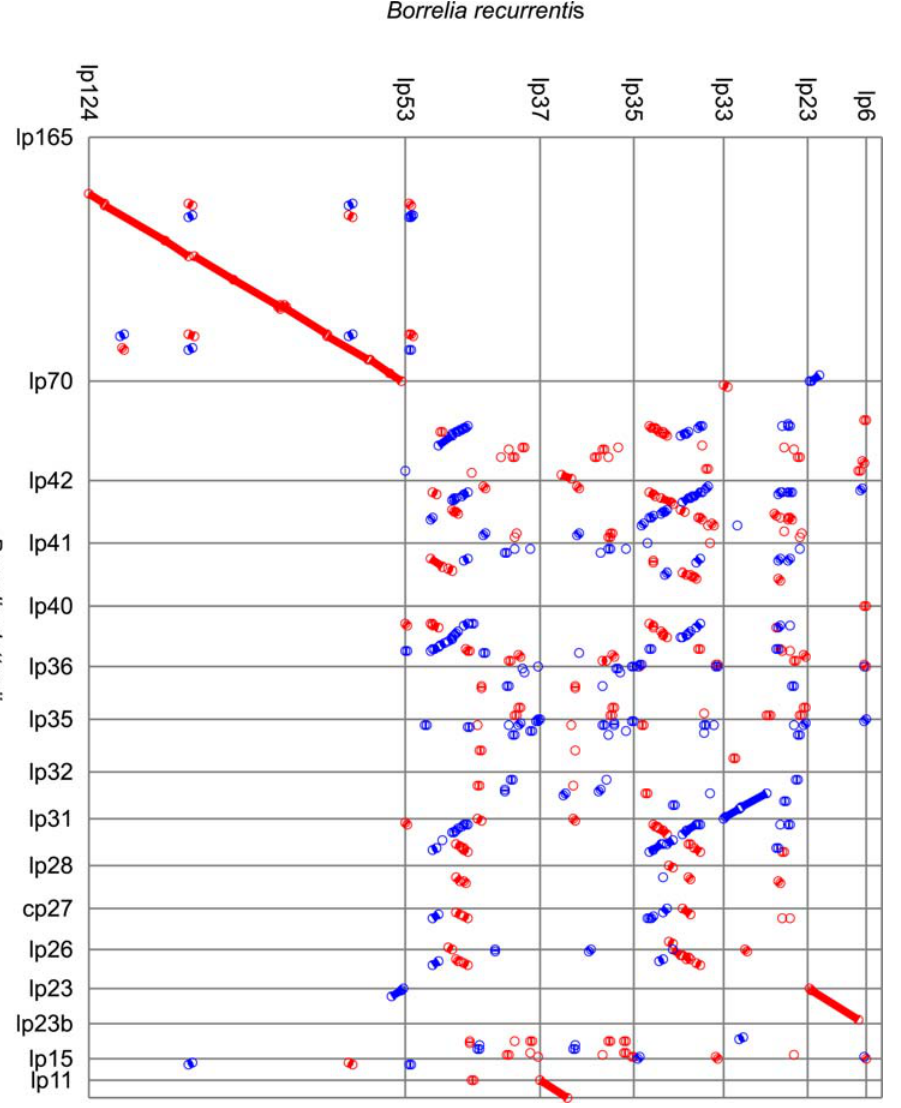
Figure 2. Dot plot showing the extensive similarity between B.recurrentis and B.duttonii plasmids. This figure was constructed using the NUCmer program from the MUMmer package. Red segments correspond to same strand matches, while blue segments correspond to opposite strand matches.